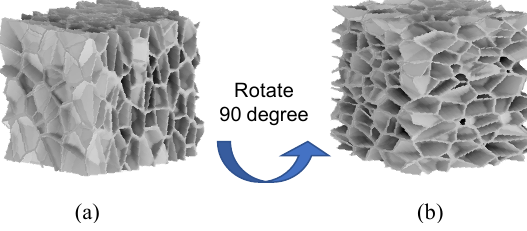
Fig.2. External view of (a) vertical ellipsoidal cell model, and (b) horizontal ellipsoidal cell